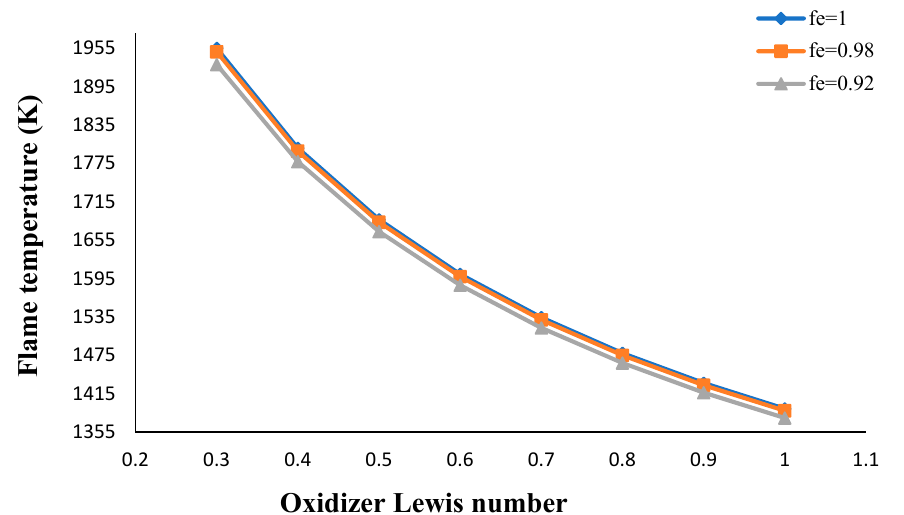
Figure 6. Flame temperature against the oxidizer Lewis number for several porosity factors.